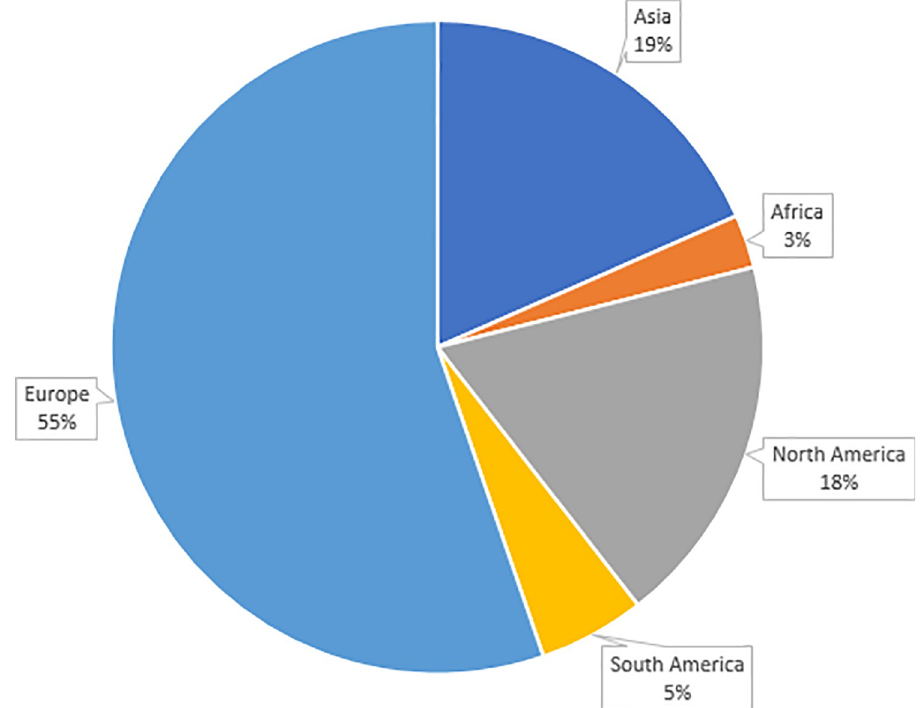
Fig 3. Geographic distribution of the included